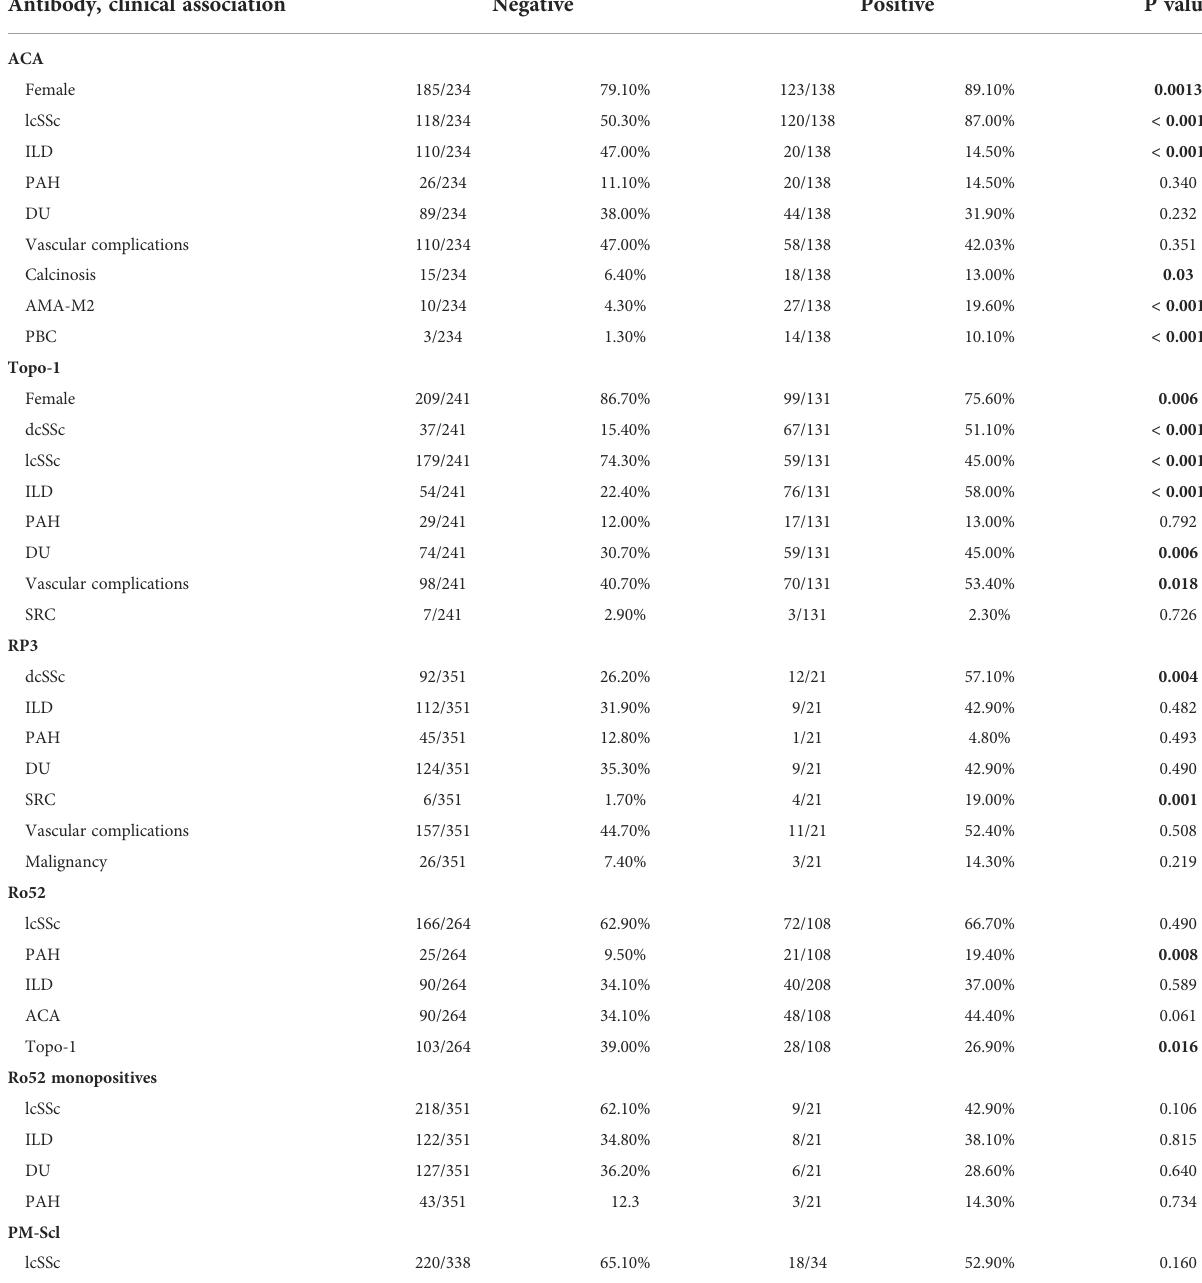
TABLE 5 Clinical characteristics of the SSc-associated